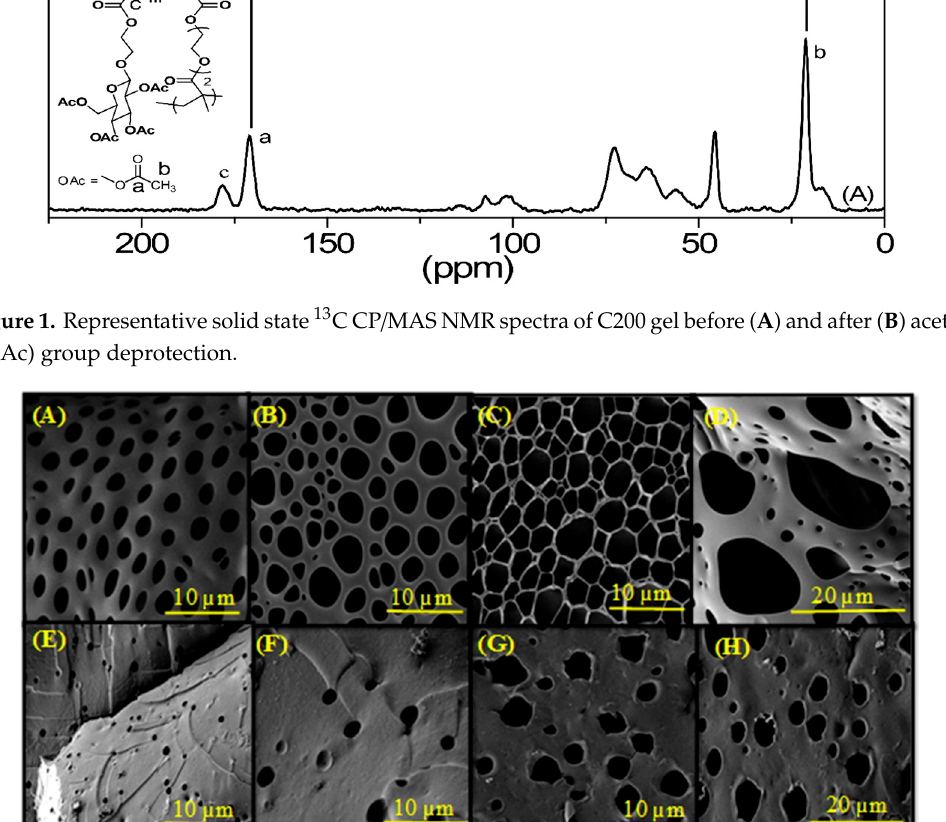
Figure 2. FE-SEM micrographs of gels. ( A ) C50; ( B ) C100; ( C ) C200; ( D ) C300; ( E ) DC50; ( F ) DC100; ( G ) DC200; and ( H )